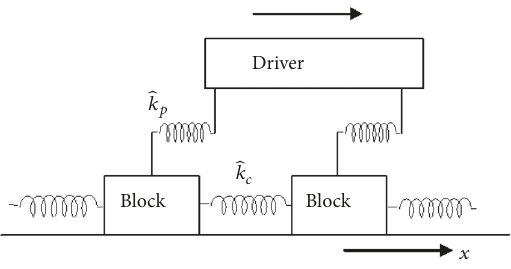
Figure 2: Schematic diagram of the spring-block model. The blocks Figure 1: Schematic diagram of the spring-block model contains a are coupled to each other by harmonic springs with stiffness of square array of slider blocks. The blocks are coupled to eachother by ̂𝑘 ̂𝑘 harmonic springs with stiffness of 𝑐 . The block was dragged using springs of stiffness 𝑐 . The block was dragged using ̂𝑘 moving at a constant speed 𝑉 𝑝𝑙 V . springs of stiffness 𝑝 by a driver plate with speed